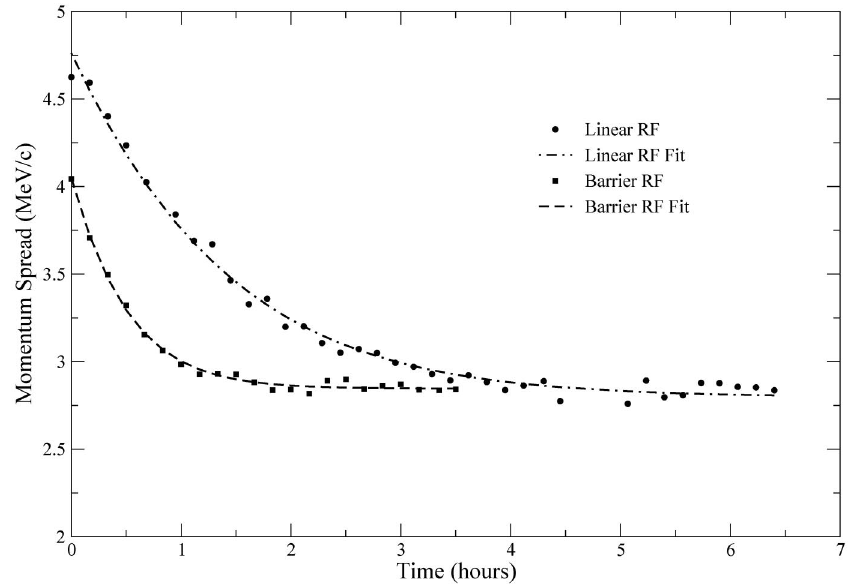
FIG. 3. Evolution of the beam rms momentum spread for the linear and barrier rf buckets. Points are the measured data, the lines are the